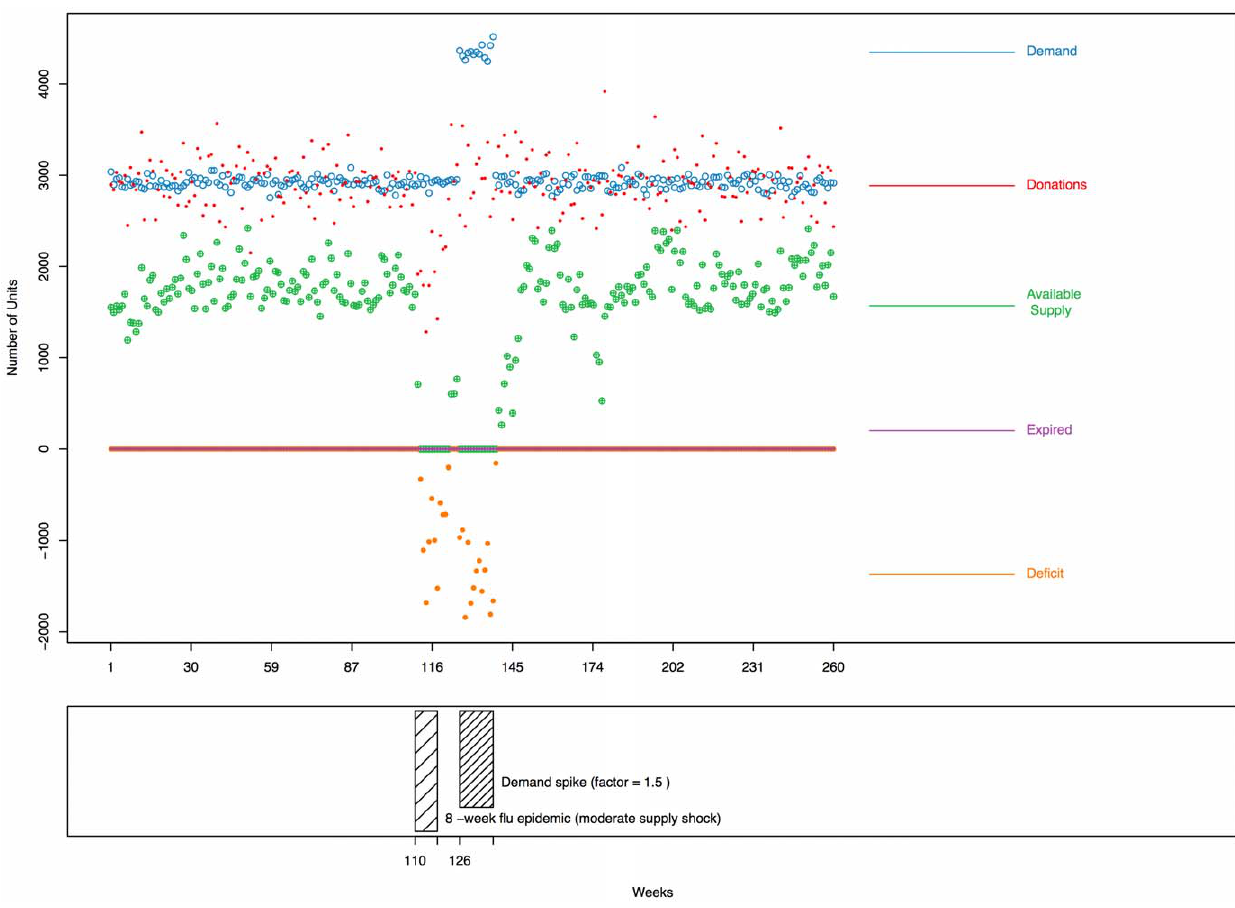
Figure 4. Time series of blood donations, demand, available supply, expired units, and deficit during a period with a moderate supply shock and a demand spike, with no enhanced recruitment, from one run of the simulator over 260 weeks after a 5 , 000 -week burn-in period (not shown). The supply shock (flu epidemic) starts in Week 110 and lasts for 8 weeks, and the demand spike starts in Week 126 and lasts for 12 weeks, as shown in the bottom plot.